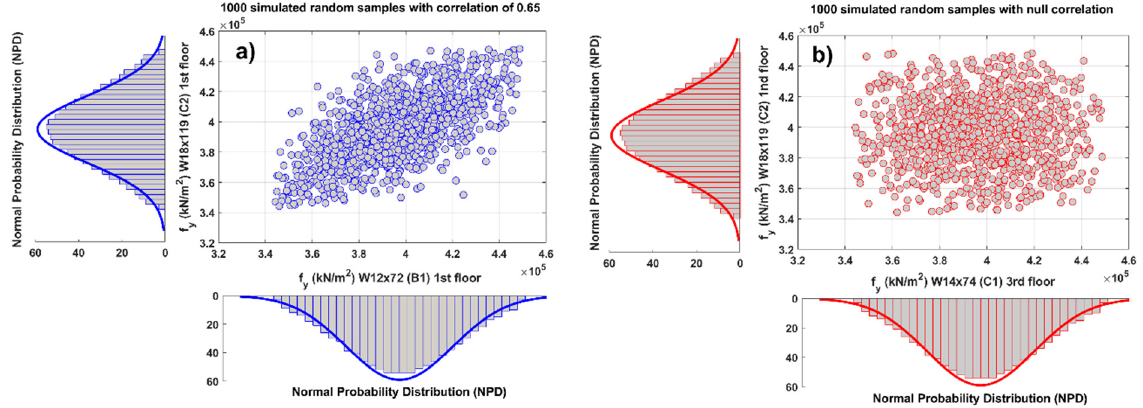
Figure 2. An example of the ( a ) NPD with a 0.65 correlation and ( b ) NPD with a null correlation